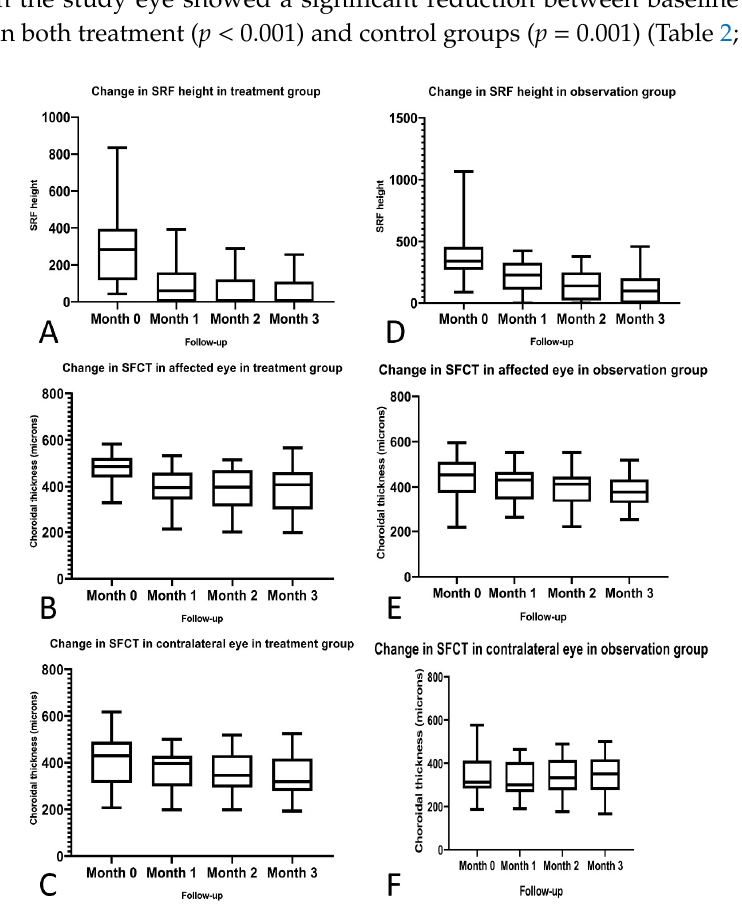
Figure 1. Changes in subretinal fluid (SRF) height and sub foveal choroidal thickness (SFCT) in both treatment and observation groups. ( A – C ): Box and whisker plots showing the change in the SRF height and SFCT in the treatment group at baseline, 1-,2- and 3-month visits. ( D – F ): Box and whisker plots showing the change in the SRF height and SFCT in the observation group at baseline, 1-,2- and 3-month visits.